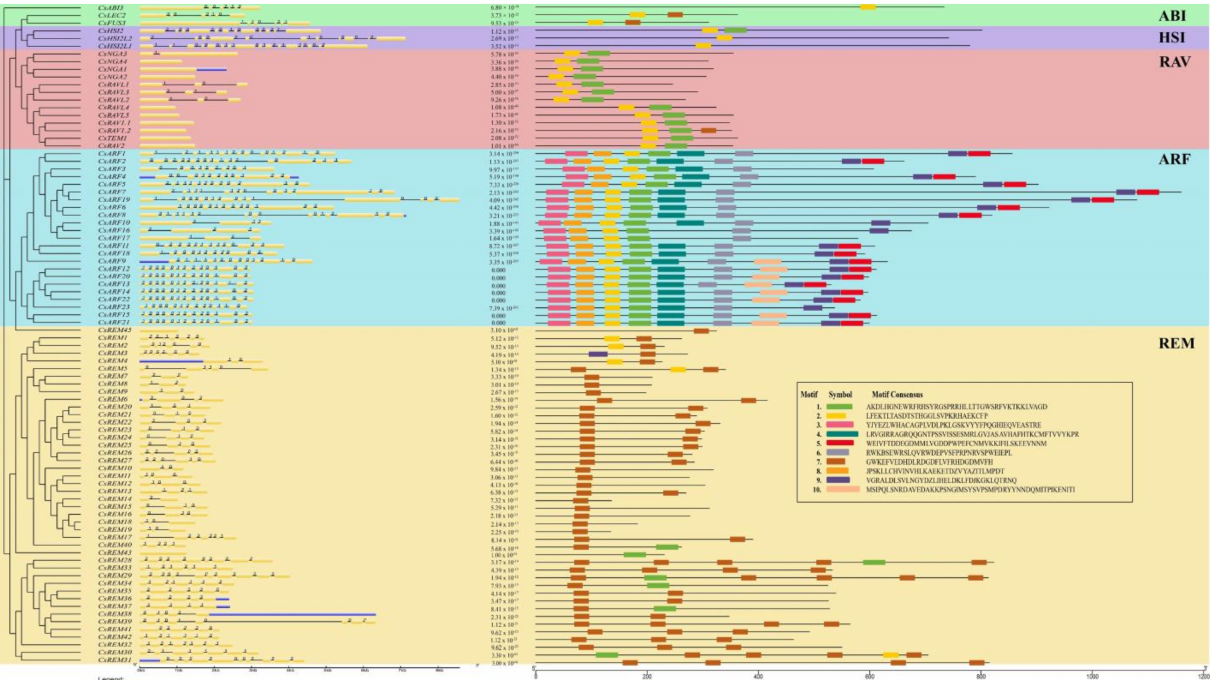
Figure 2. Gene structure prediction and protein motif analysis. On the left panel are the results of the gene structure analysis using GSDS, displaying the organization of exons and introns in the B3 genes. Yellow boxes represent exons, and introns are represented by lines. The right panel shows the motif structure of the B3